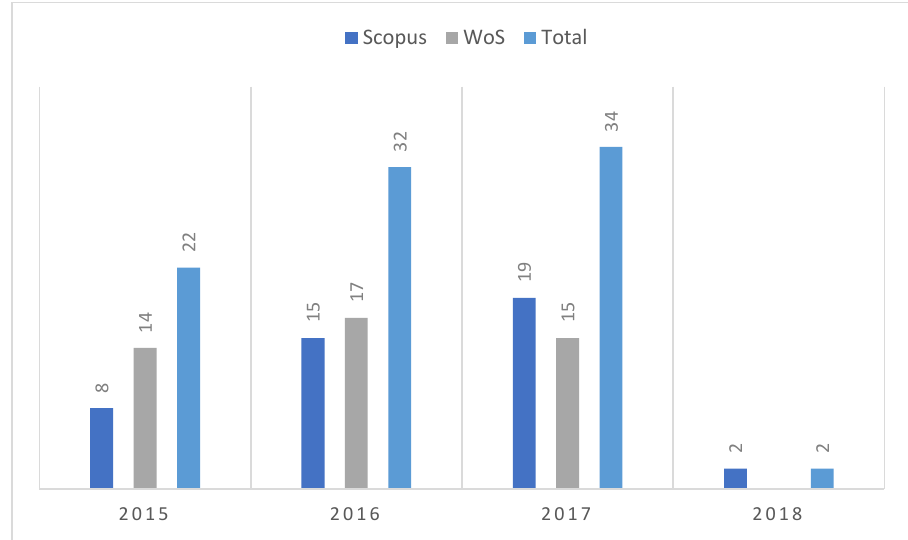
Figure 3 . Documents selected by database and by year. From 2015 to March 2018, a greater number of articles were published (78%) than conferences (22%). The difference is greater in 2017, where 94% of the documents are articles and only 6% are conferences. Table 3 shows the sets of articles according to their type and year of publication.